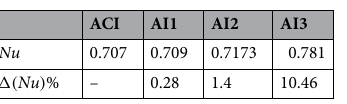
Table 3. Nusselt number versus geometry configuration at Re = 100